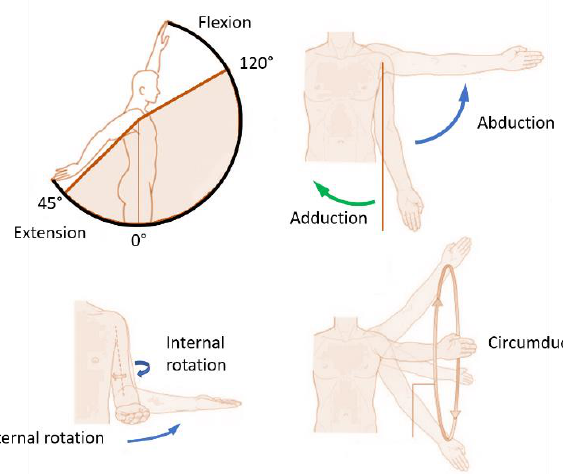
Figure 4. Shoulder joint movements.